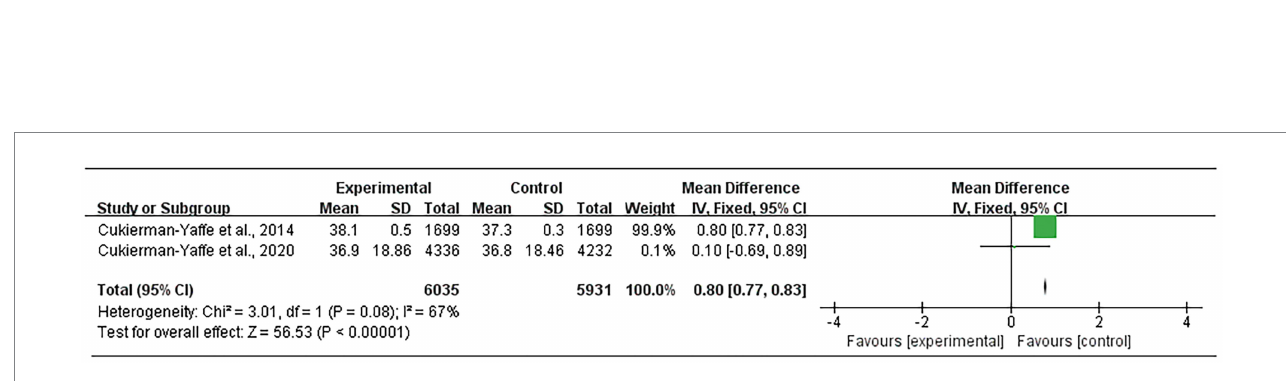
FIGURE 6 Meta-analysis of DSST by glycemic